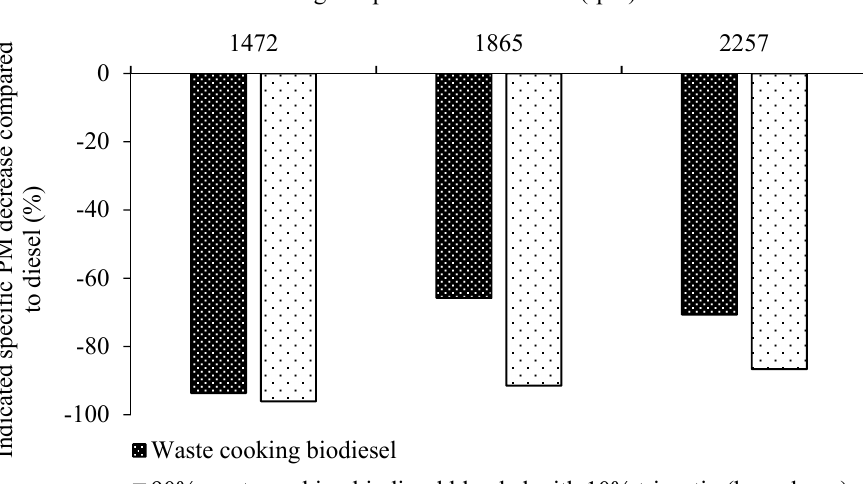
Figure 7. Indicated specific PM variation as compared with diesel [103].